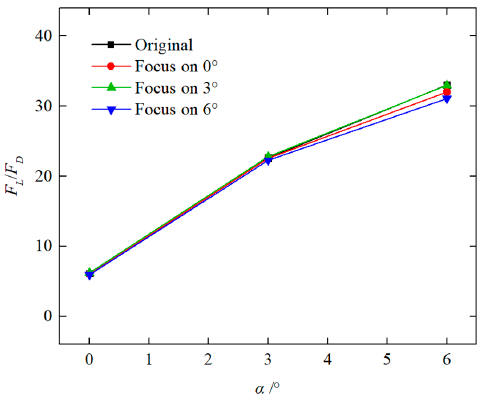
Figure 7. Comparison of lift/drag ratio F L / F D .